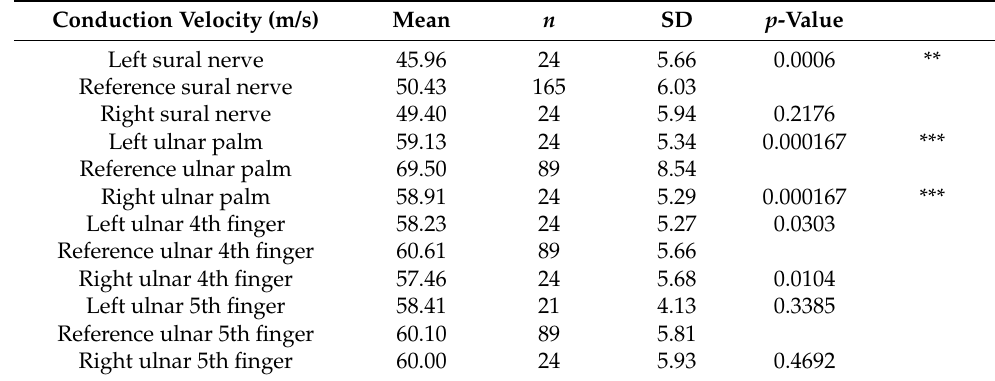
Figure 11. Box-plots for sensory neurography conduction velocities. Lower and upper box bounda- ries represent the 25th and 75th percentiles, respectively. The line inside the box represents the me- dian and the lower and upper whiskers represent the 10th and 90th percentiles. Filled circles repre- sent values ≥ two standard deviations outside reference values. ** and *** indicate statistically sig- nificantly lower median values compared to the reference material, with Bonferroni-corrected p - values corresponding to 0.01 and 0.001, respective-ly.3.6. Correlation with Symptoms.